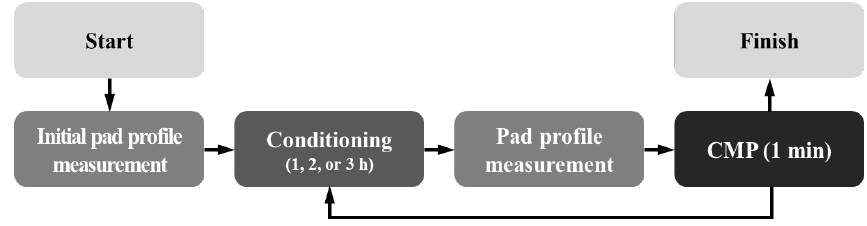
Figure 6. Procedure of conditioning and CMP